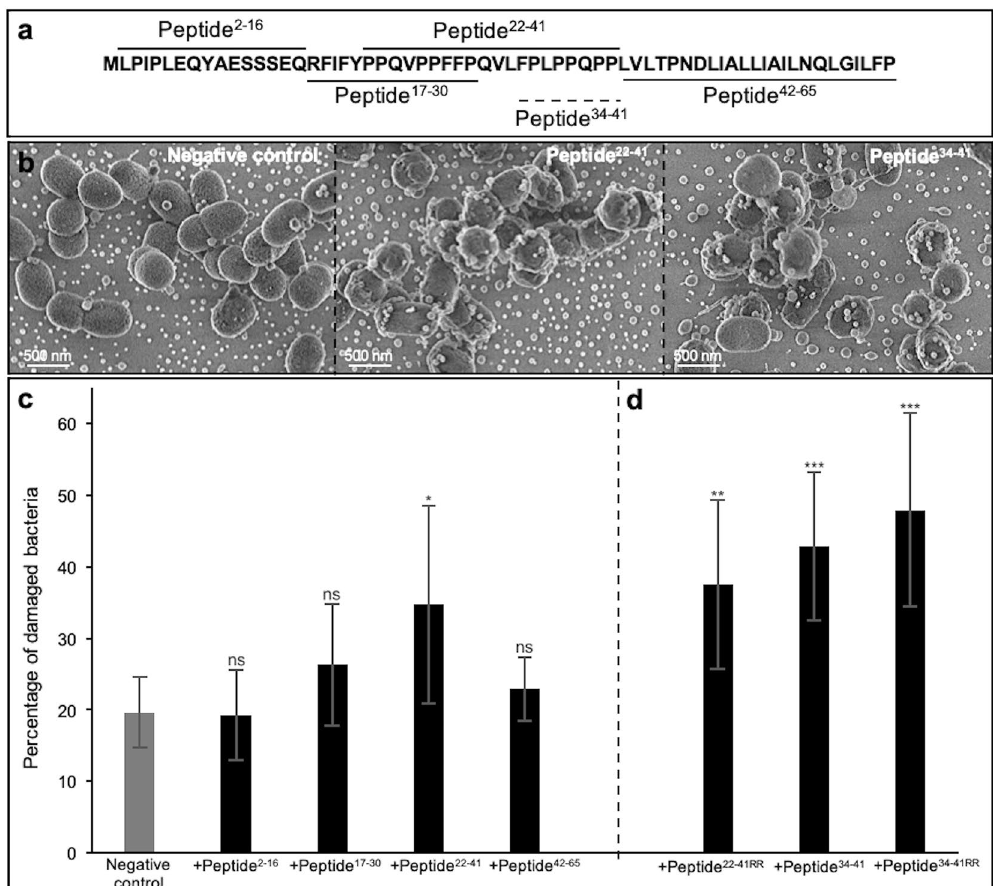
Figure 9. Effect of peptides on the membrane of P. gingivalis . ( a ) Amino acid sequence of full-length SCPPPQ1 and the corresponding five peptides generated. Peptide names are derived from the amino acid position in the full-length protein and are indicated in superscript. The dotted line represents the smallest peptide created. ( b ) SEM micrographs showing bacteria from the negative control, + peptide 22–42 , and + peptide 34–41 treated samples at 2 h. Micrographs are representative from five different experiments. ( c,d ) Quantification of the number bacteria with damaged membrane in percentage from the negative control and + peptides treated samples. Two peptides were synthesized in which two arginines were added on the C-terminal end; these are referred to as peptide 22-41RR and peptide 34-41RR . Data are represented as mean ± standard error of mean ( n = 5). Significance was determined by two-tailed Student’s t test analysis (ns: p > 0.05; * p < 0.05; ** p < 0.01; *** p <